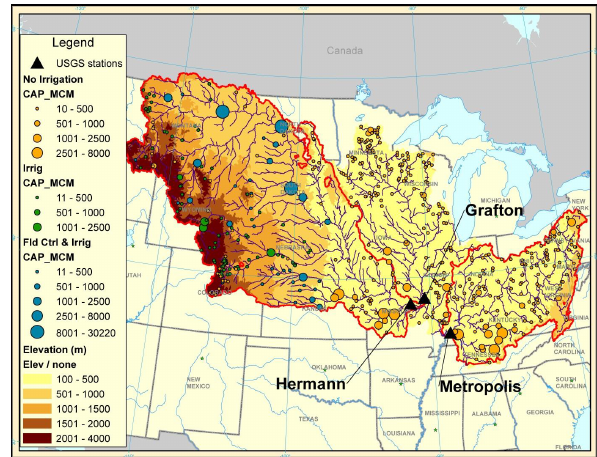
Fig. 1. GRanD reservoir database by type of operating rules over the three regions of the US Midwest targeted in this study: Missouri, Upper Mississippi and Ohio. Flow is validated at the outlet of the three regions: Missouri at Hermann (06934500), Upper Mississippi at Grafton (05587450) and Ohio at Metropolis